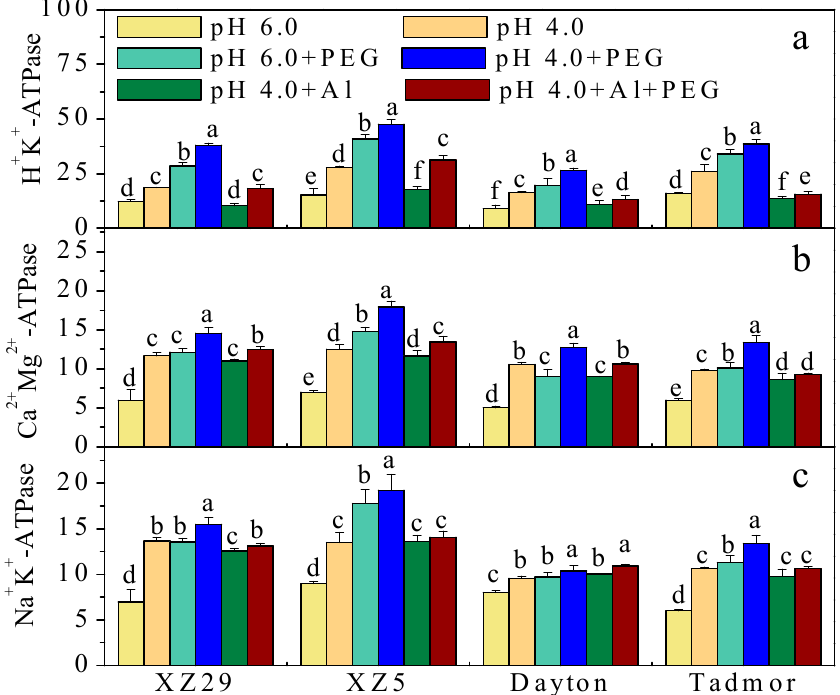
Figure 1. Effects of pH, polyethyleneglycol (PEG) alone, Al alone, and combined (pH 4.0+Al+PEG) stresses on ( a ) H + -ATPase, ( b ) Ca 2+ Mg 2+ -ATPase and ( c ) Na + K + -ATPase of four barley genotypes seven days after treatment. Error bars represent SD values ( n = 6). Different letters indicate significant differences among the treatments within each genotype according to Duncan’s multiple range tests with p <